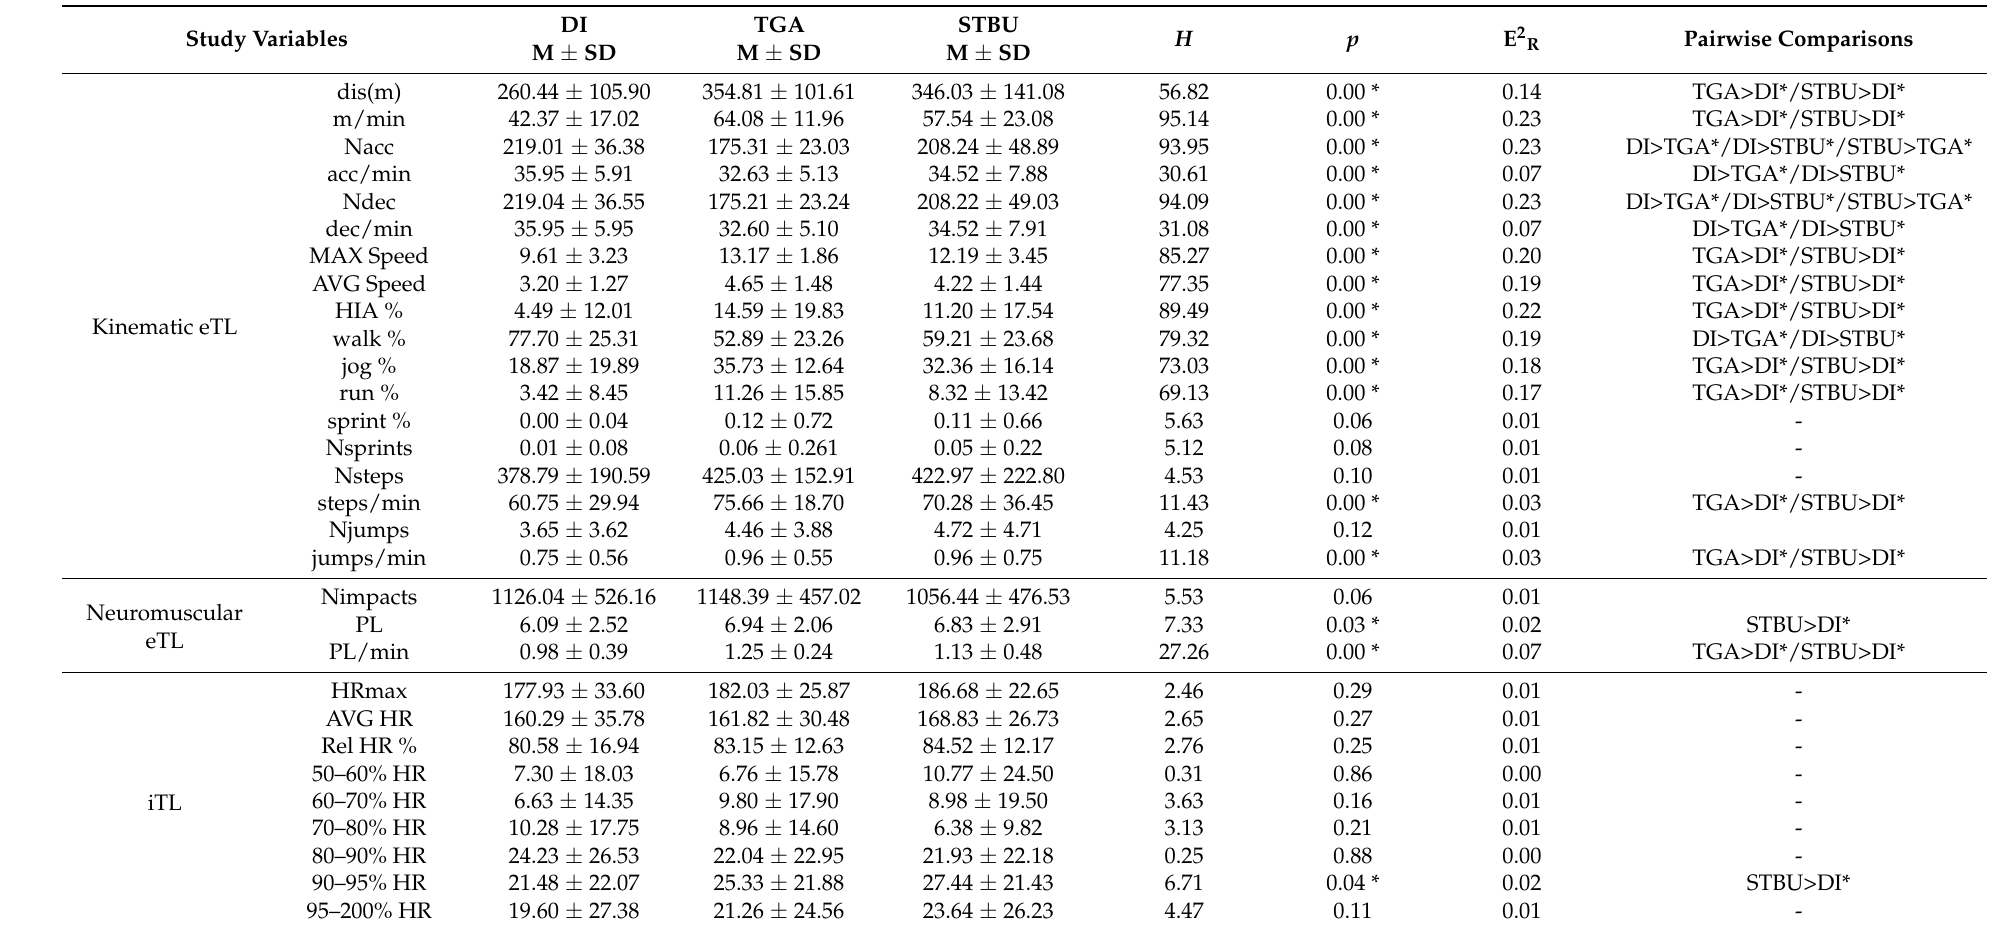
Table 2. Results of the assessment tests (pre-test/post-test) according to the teaching